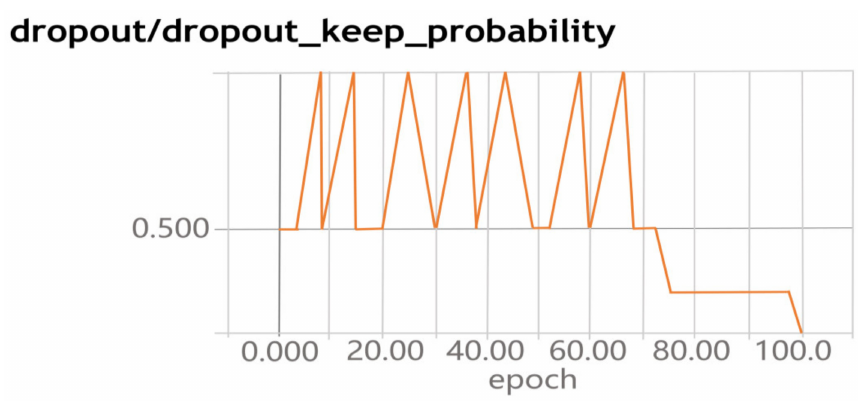
Figure 8. Dropout change